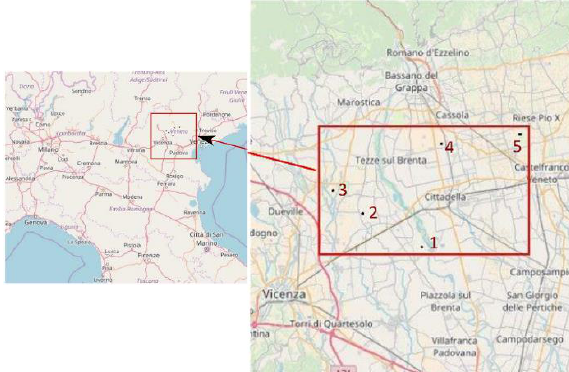
Figure 1. Study area with five sites: 1 Piciacio, 2 Albereria, 3 Palmirona, 4 Rossano, 5 Dussin